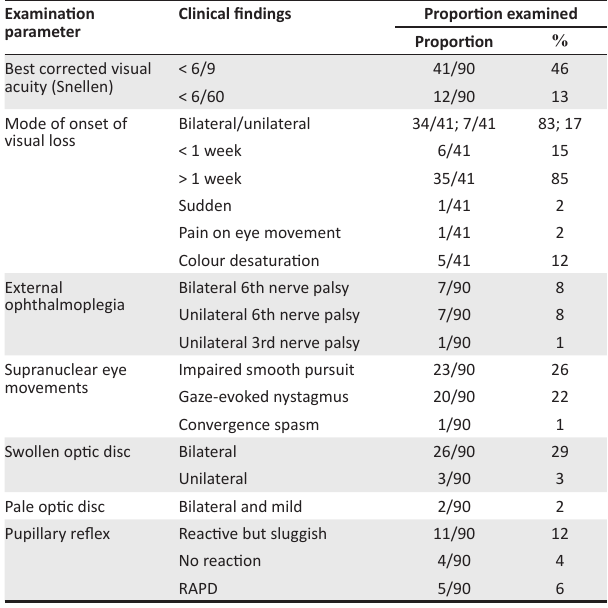
TABLE 1: Demographic data, cerebrospinal fluid pressure and CD4 count of 90 cryptococcal meningitis patients. Patient characteristics Patient data